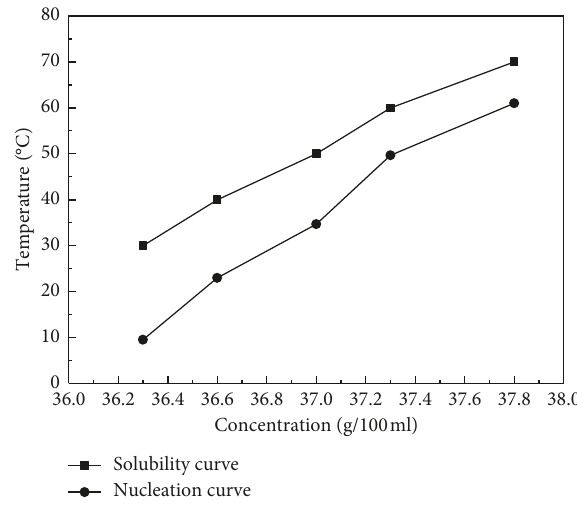
Figure 4: Metastable zone width of sodium chloride.